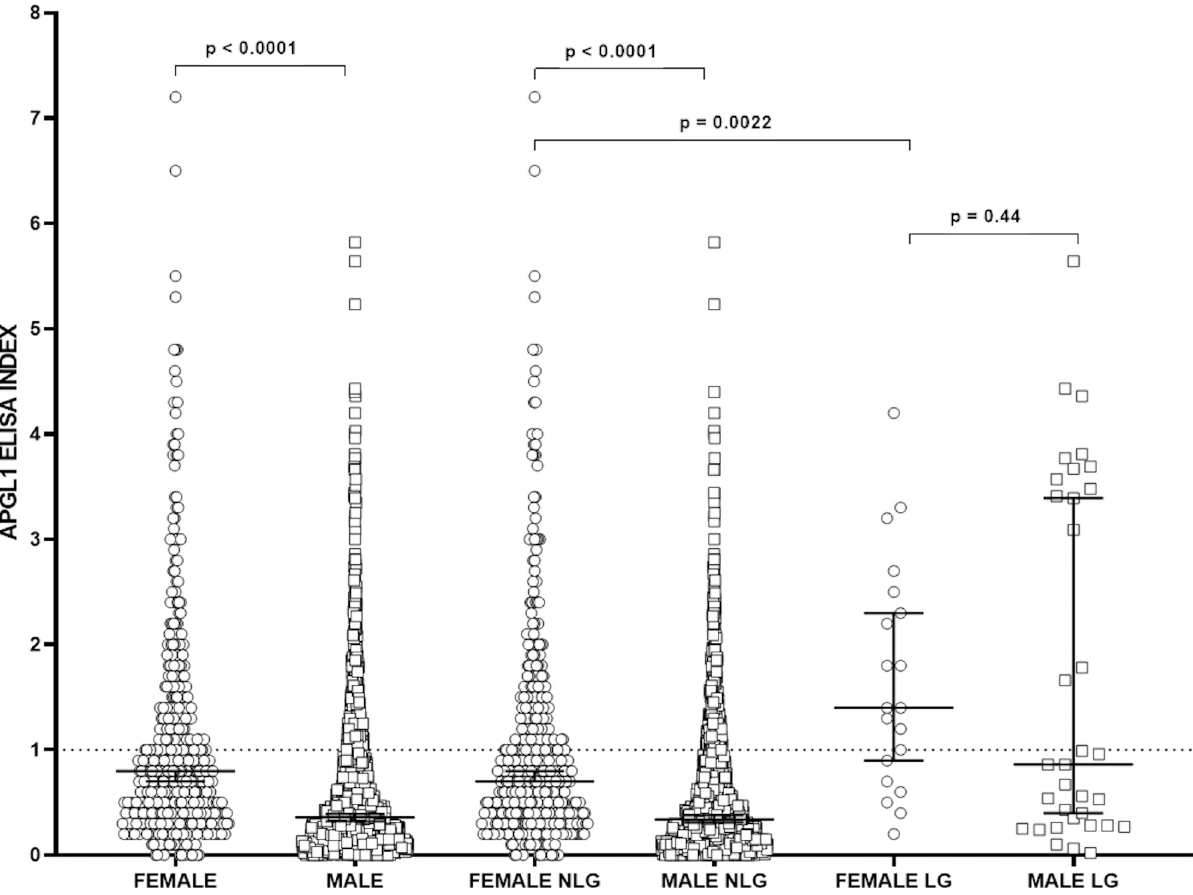
Fig 4. Comparison of IgM antibody levels by indirect ELISA against PGL-I antigen among all men and women evaluated (Male and Female groups), and among male and female non- leprosy patients (NLP) and all leprosy patients (LP). Serum levels were compared by the Mann-Whitney test. OD: optical